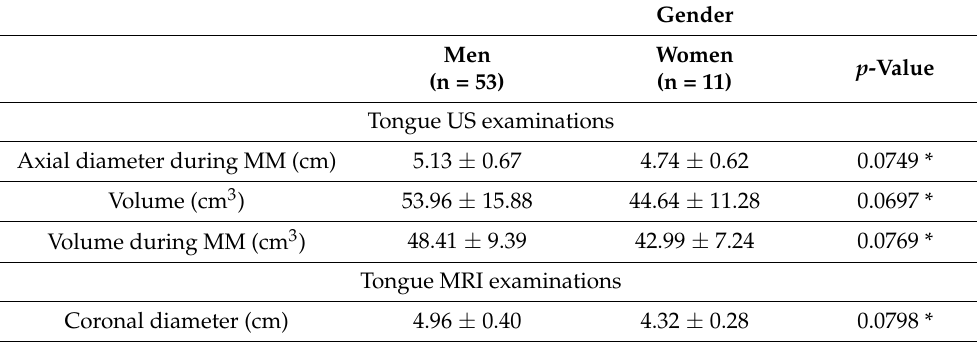
Table 2. US and MRI parameters of the tongue in male and female patients. Parameters show the mean ± SD values. * indicates the significant difference at p < 0.1 Only significantly different parameters are shown in the